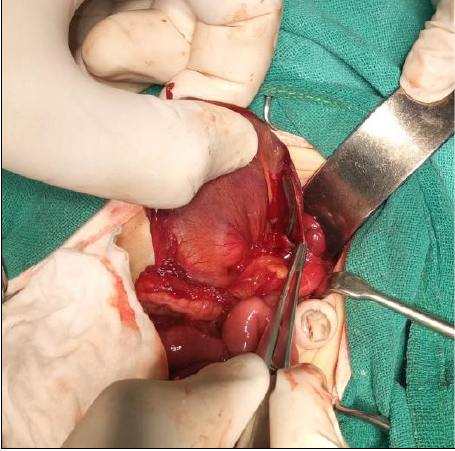
Figure 2: Operative picture showing gastric perforation. On postoperative day 4, he again started having ab- dominal distension. The septic profile revealed raised counts TLC 21000/cmm, CRP 140 mg/L, and falling platelets 1.2 lacs/cmm. Venous blood gas study revealed metabolic acidosis. On re-exploration, the gastric repair was found intact. Instead, a perforation in the left transverse colon was seen; no other ab- normality in the small or large bowel could be appre- ciated. A divided stoma was created at the perforation site and multiple colonic biopsies were taken distal to the perforation. The baby succumbed after a few Figure 1: X-ray abdomen showing huge hours of re-exploration. Histopathology revealed pneumoperitoneum. aganglionosis in sigmoid colon and colo-rectal junction; ganglion cells were present at the site of